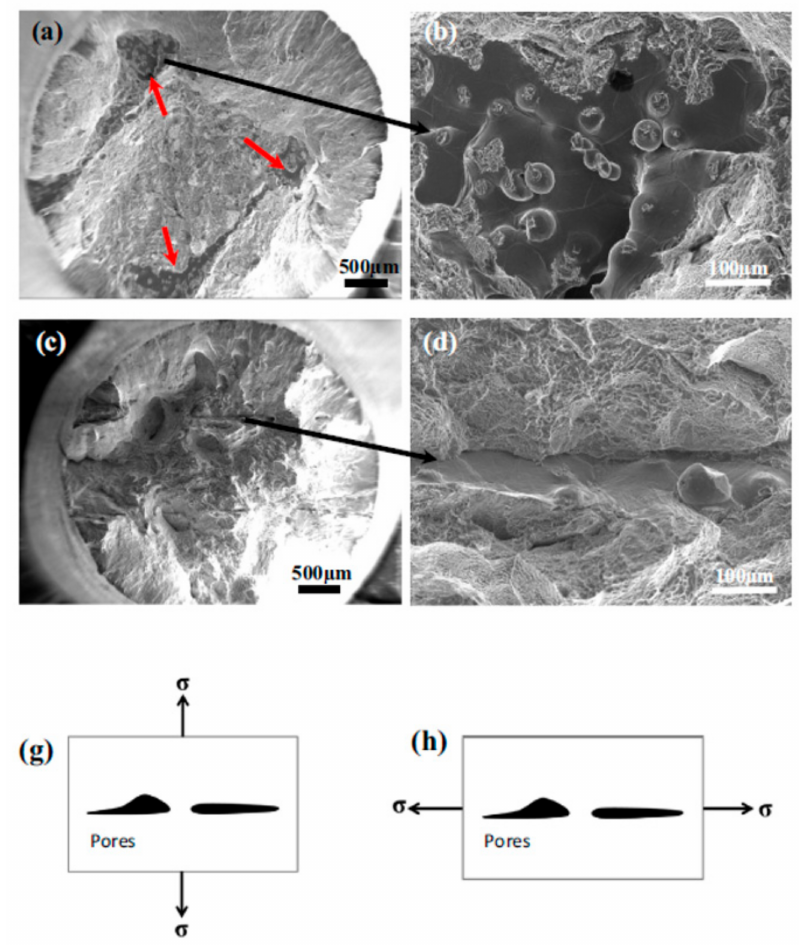
Figure 15. SEM micrographs of the fracture surfaces of as-DED samples, ( a , b ) vertical samples; ( c , d ) horizontal samples; ( g , h ) schematic illustration of tensile loading direction relative to the orientations of the angular or flat interlayer pores in vertical and horizontal samples, respectively (reproduced with permission from [88] Copyright Elsevier,